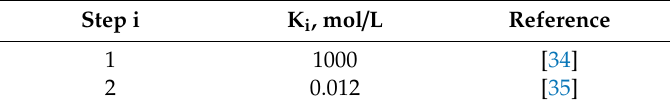
Table A1. Dissociation constants of sulphuric acid at 25 °C.